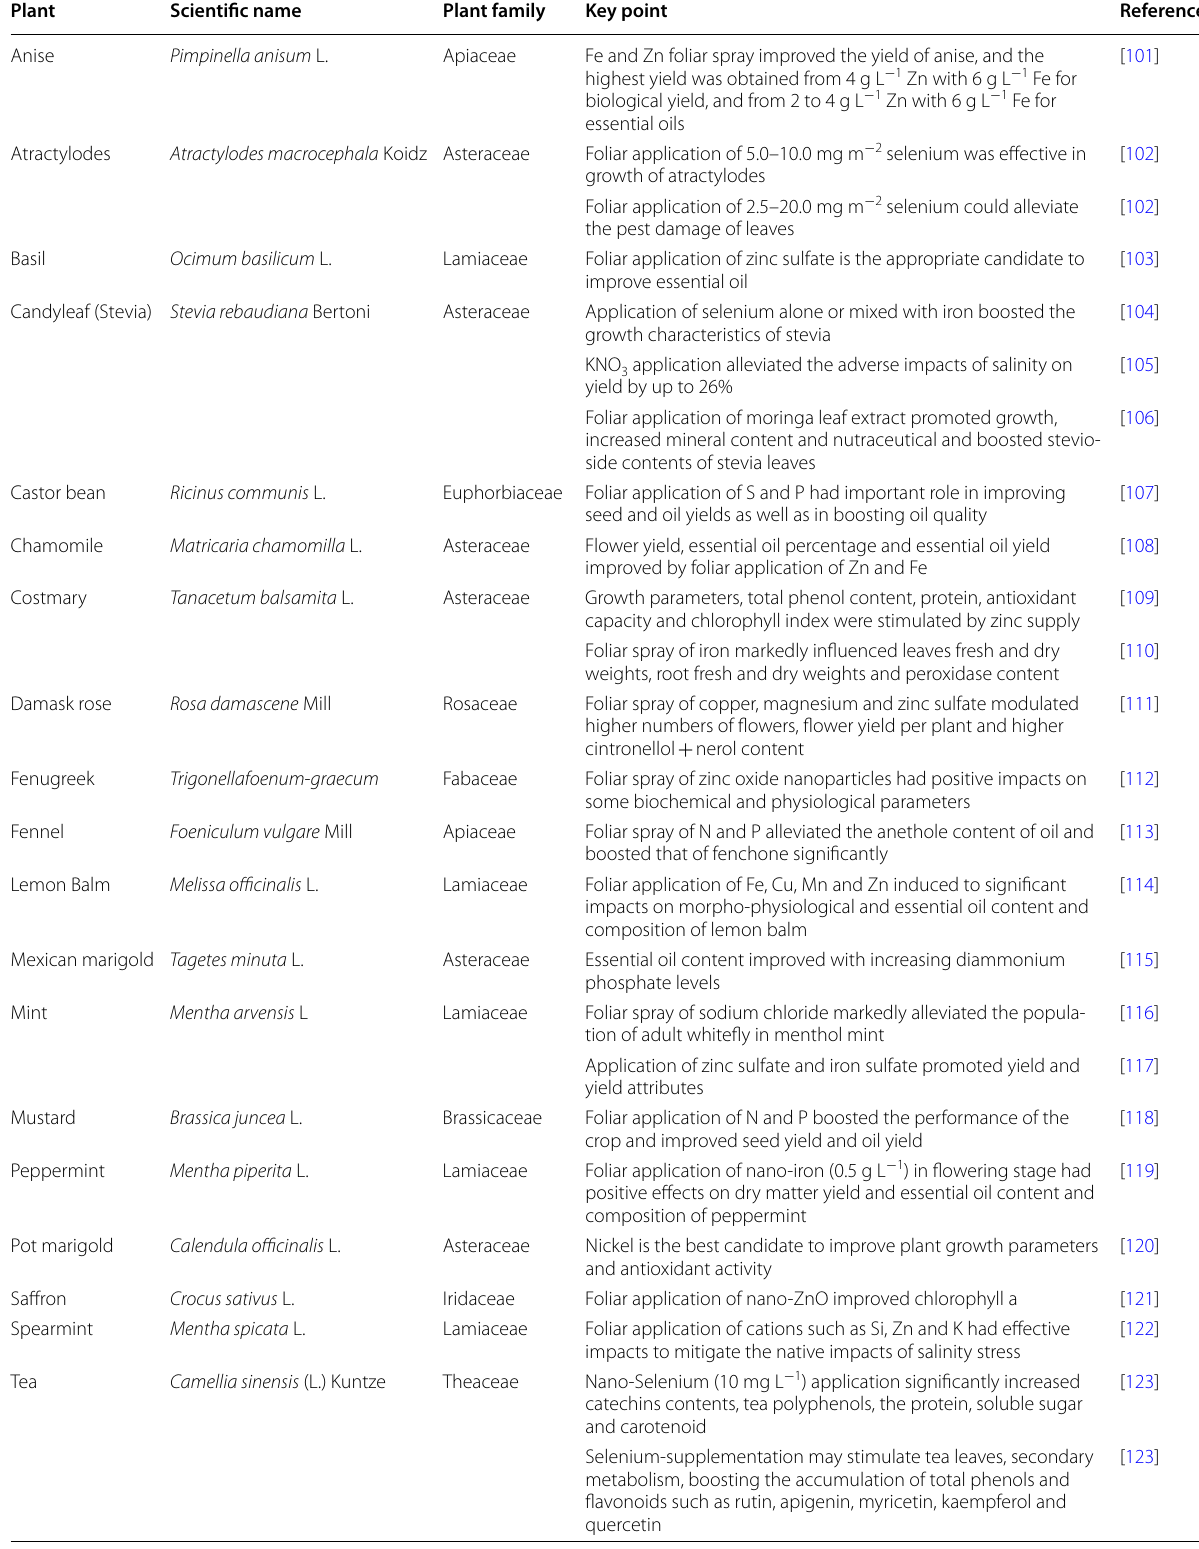
Table 1 The most notable impacts of foliar application of nutrients on medicinal and aromatic plants